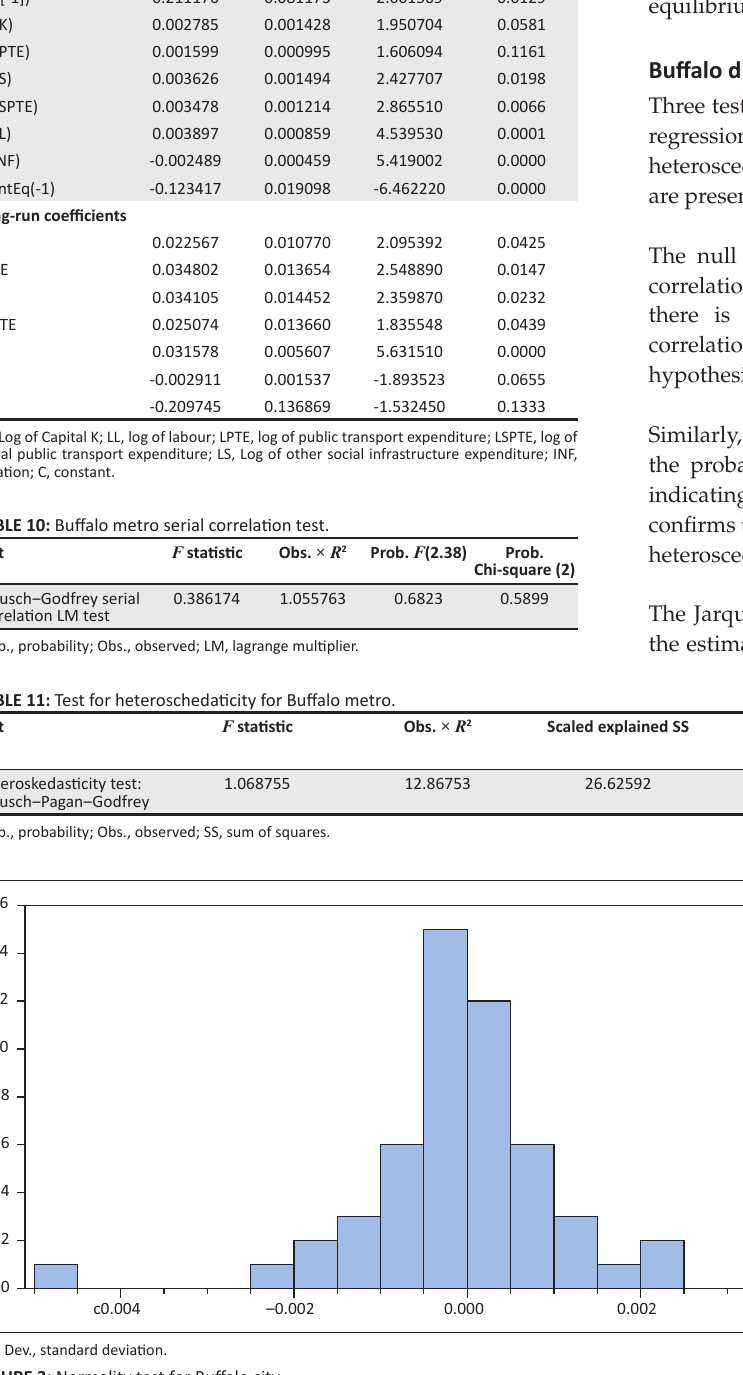
FIGURE 3: Normality test for Buffalo